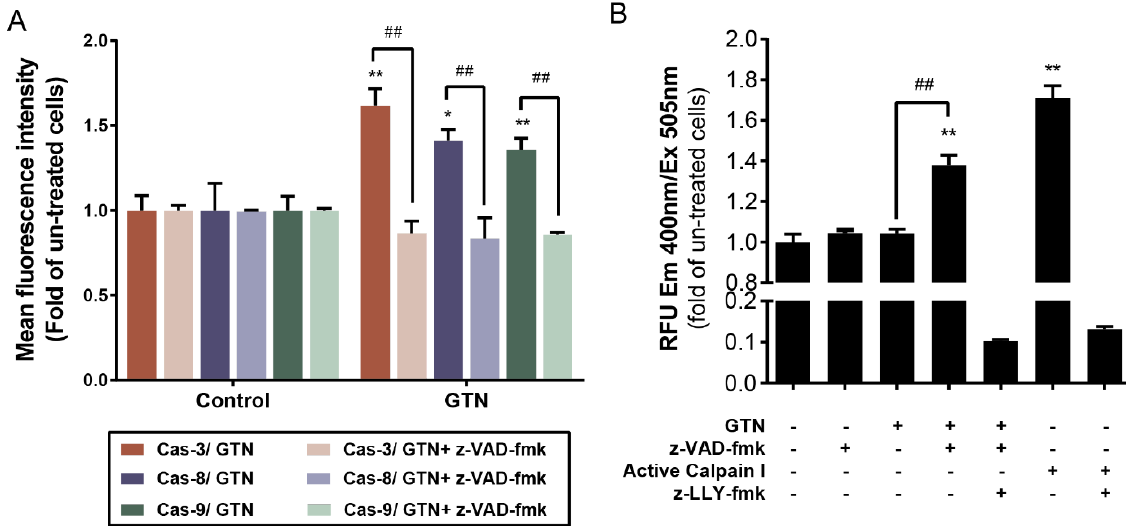
Figure 2. Caspase - independent MDA - MB - 231 necroptosis but via calpain enzyme activity . Caspase - 3, - 8, and - 9 activities in the presence of GTN at an inhibitory concentration of fifty - percent with or without z - VAD - fmk co - treatment compared with the z - VAD - fmk treatment alone as control ( A ) . Calpain activity increased in GTN plus z - VAD - fmk, which was measured by fluorescence intensity, but the effect was inhibited by a pharmacological calpain tripeptide inhibitor ( z - LLY - fmk ) that confirmed the mode of programmed cell death to be necroptosis ( B ). Data were obtained from three independent experiments in triplicate, the significance of statistical values when compared to the control ( without treatment ) are marked with * p < 0 . 05 or ** p < 0 . 01 and compared to GTN alone is marked with ## p < 0 . 01 .